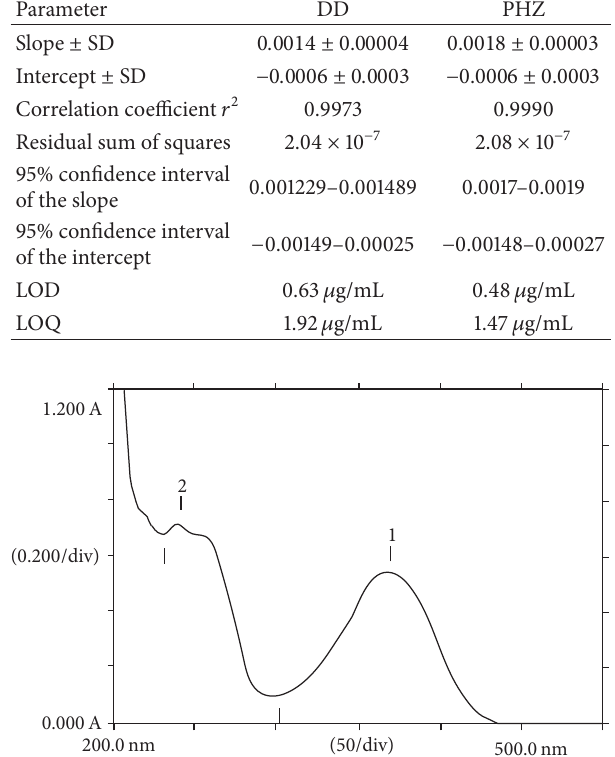
Figure 2: Normal spectrum of DD (1) and PHZ (2) aqueous mixture.